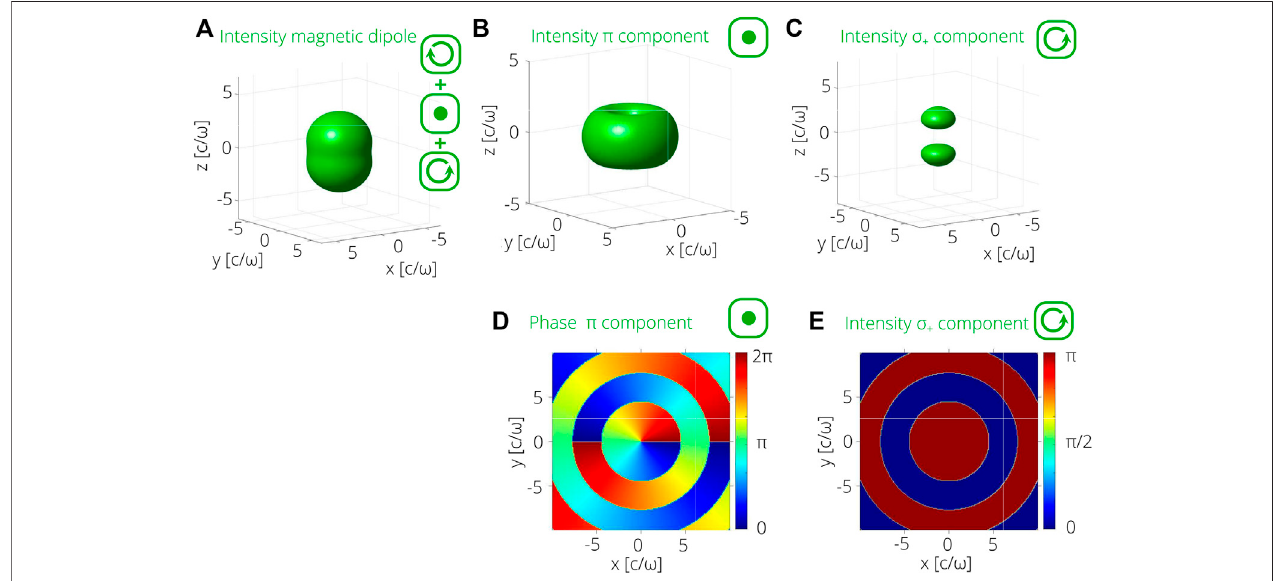
FIGURE 4 | Isosurfaces of an magnetic dipole Y ( M ) 11 spherical wave at 40% of the intensity divided into: (A) total intensity; (B) σ − polarization component; (C) π polarizationcomponent; and (D) σ + components ofthepolarization.In (E) – (G) thephasedistributions atthe z